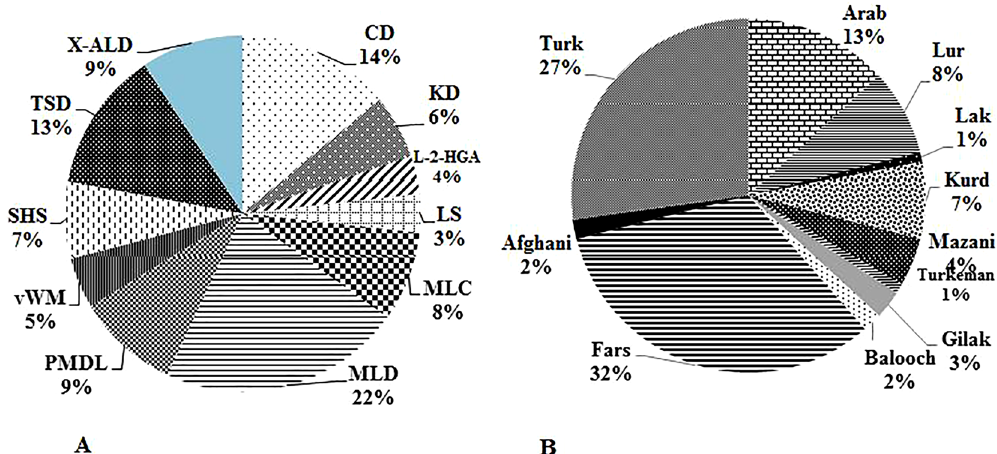
Figure 1. ( A ) The distribution of the most common diagnosed leukodystrophies (86 of 114 patients) in our studied patients include 19 of 86 (22%) MLD, 12 CD, 11 TSD, 8 X-ALD, 8 PMLD1, 7 MLC, 6 SHS, 5 KD, 4 vWM, 3 LS and 3 L-2-HGA. ( B ) The distribution of 114 leukodystrophy genotype positive patients in Iran based on